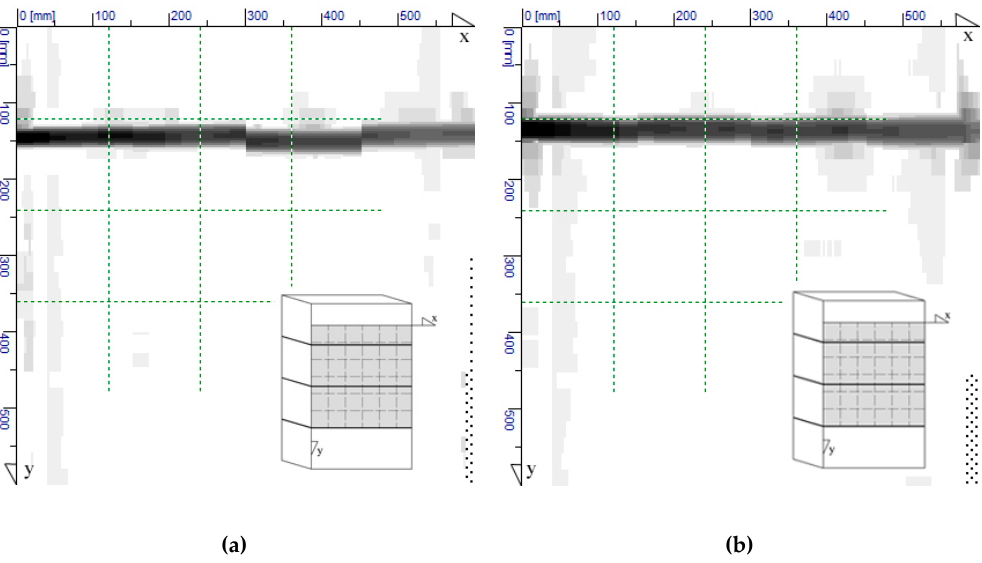
Figure 11. Results from electromagnetic tests of the masonry specimens, ( a ) masonry specimen No. 1, ( b ) masonry specimen No. 2.